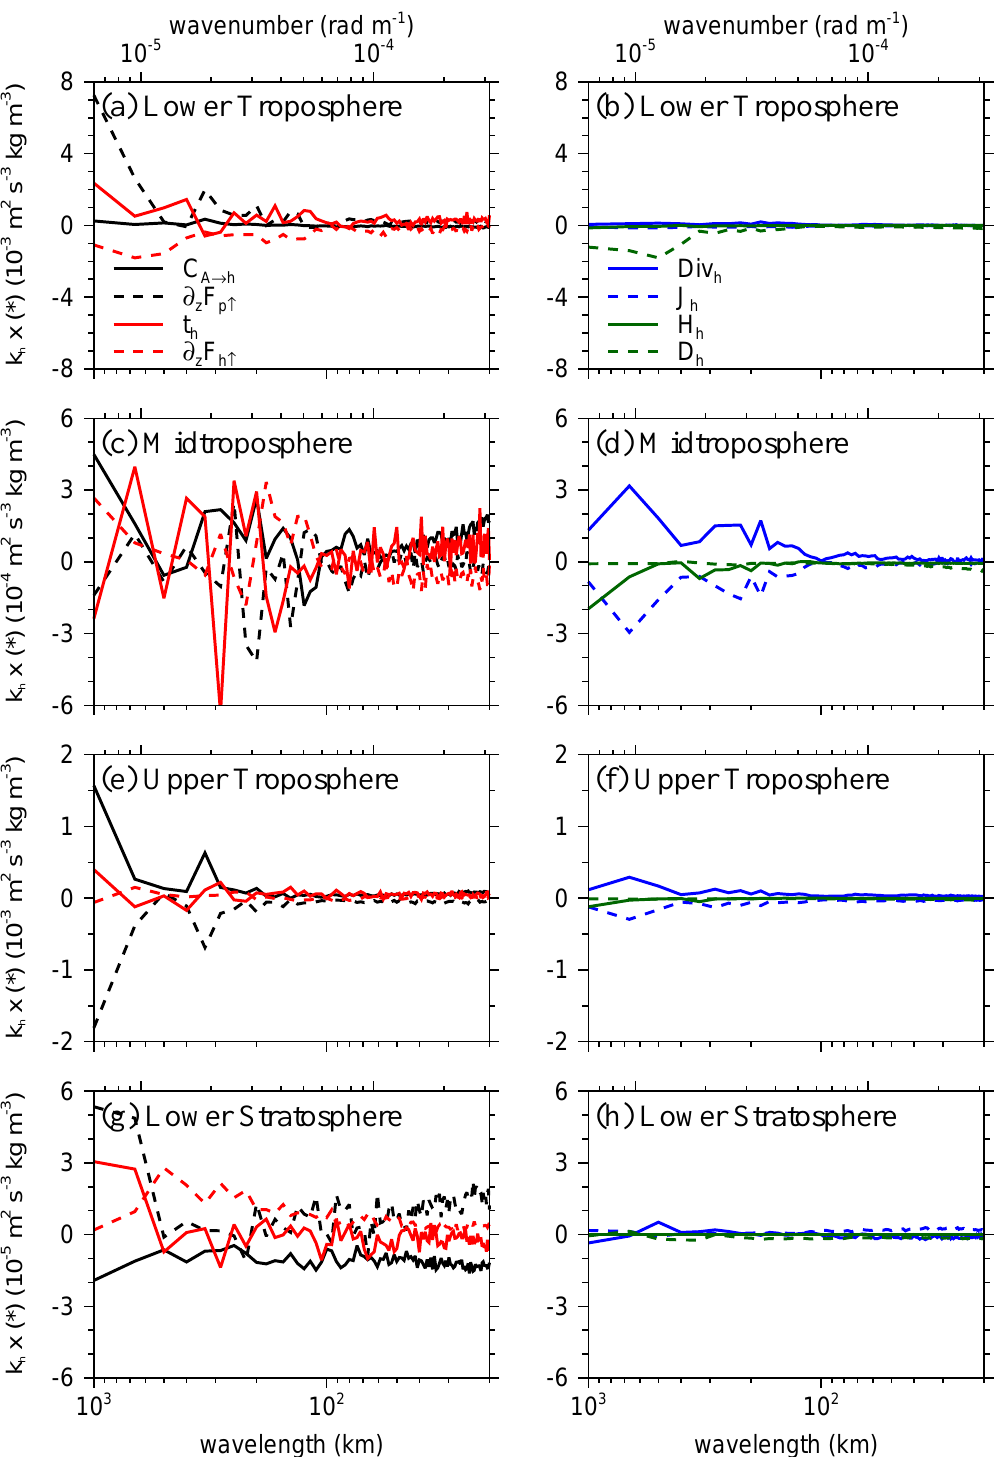
Figure 7. Spectral HKE budget terms averaged vertically over the ( a , b ) lower troposphere, ( c , d ) midtroposphere, ( e , f ) upper troposphere, and ( g , h ) lower stratosphere, and in time over the intensification period. The legend for the left panels is given in ( a ) and that for the right panels in ( b ). The asterisk * represents any one of the budget terms. The spectra are multiplied by k h to preserve area in log–linear coordinates.